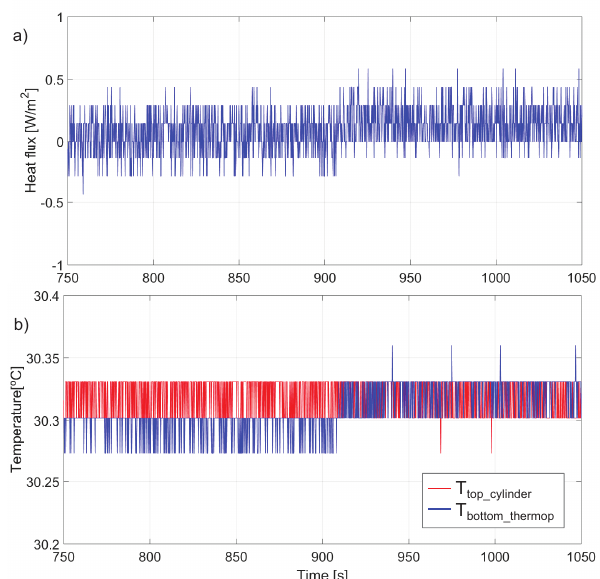
Figure 12. Closed loop experimental results. At approximately t = 907 s the thermopile is placed on top of the cylinder. Evolution around t = 907 s of: ( a ) the instantaneous heat flux in the thermopile ( ∆ V ( t ) / S ), ( b ) the temperatures at the top of the cylinder and at the bottom of the thermopile.